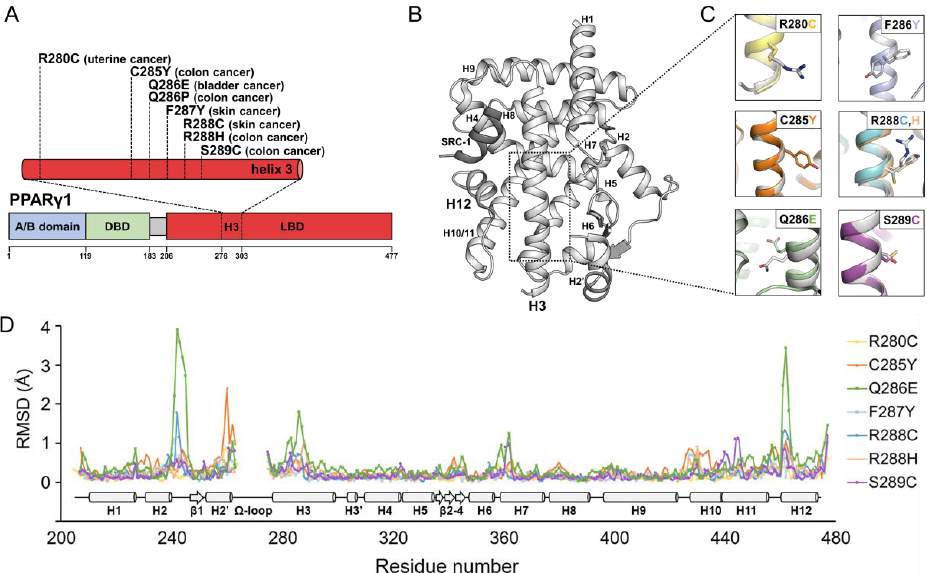
Figure 1. The helix H3 mutations of PPARγ ligand-binding domain (LBD) found in cancers and their crystal structures. ( A ) Schematic diagrams displaying domain compositions and mutations in helix H3 of PPARγ LBD. Sequences are numbered according to the PPARγ1 isoform. A/B domain, DBD and LBD indicate N-terminal domain, DNA-binding domain and ligand-binding domain, respectively. ( B ) Overall structure of PPARγ LBD WT displayed as a cartoon representation colored in light grey. A SRC-1 peptide is colored in dark grey. ( C ) The structural comparisons of apo PPARγ LBD WT and mutants. The structure of PPARγ LBD WT is superposed with those of PPARγ LBD mutants. The side chains of the WT and mutated residues are shown as stick representations, in light grey color for the WT and various colors for the mutants. ( D ) The comparison of C α RMSD values for the PPARγ LBD mutant structures against the PPARγ LBD WT structure. The mutant structures of PPARγ LBD R280C, C285Y, Q286E, F287Y, R288C, R288H and S289C are compared to the PPARγ LBD WT structure in the presence of a SRC-1 peptide (PDB ID: 6JQ7). Secondary structure elements are displayed along residue